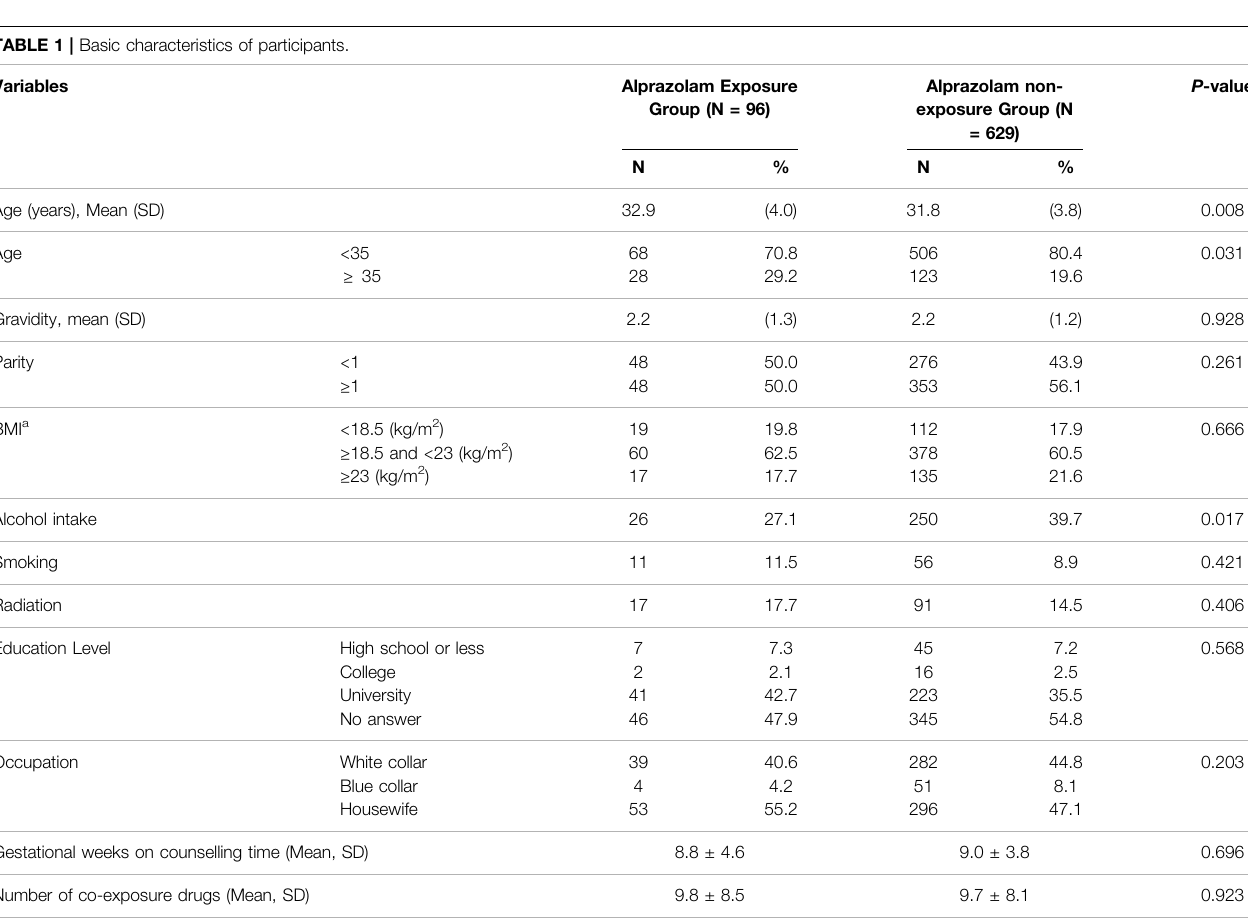
TABLE 1 | Basic characteristics of